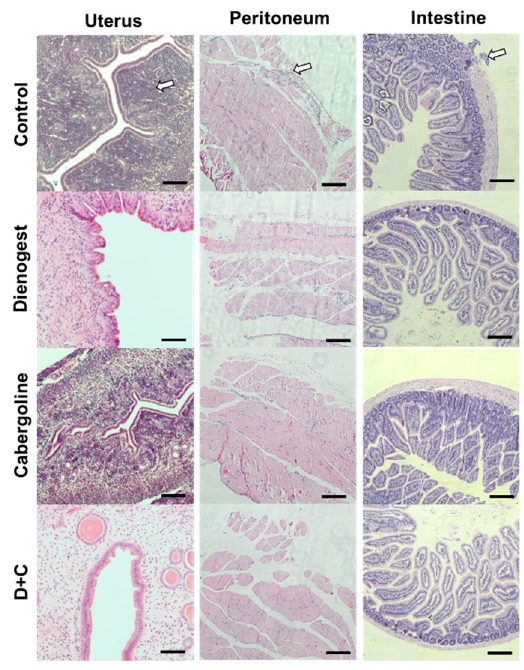
Figure 2. Histological images of the endometriosis control, Dienogest, Cabergoline, and combined treatment. The arrowhead is an endometriosis lesion; magnification, 200×; scale bar, 100 µm.